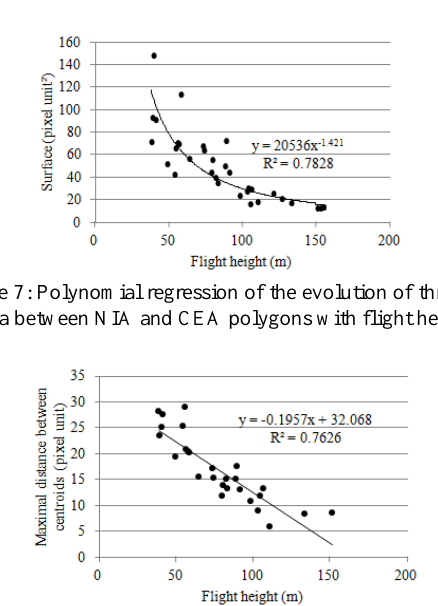
Figure 8: Linear regression between flight height and the maximal distance between centroids of two paired polygons (PPSA).